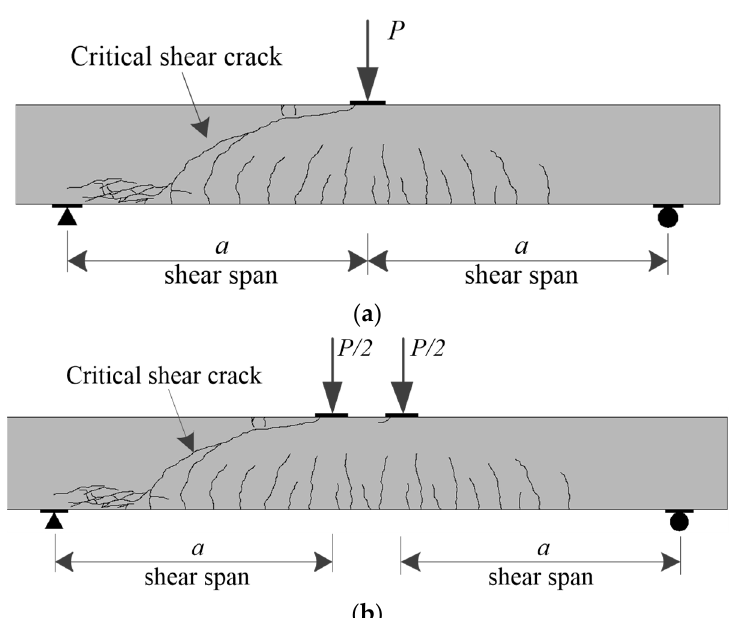
Figure 1. Typical shear test for RC beams. ( a ) three-point symmetrical loading. ( b ) Four-point symmetrical loading.